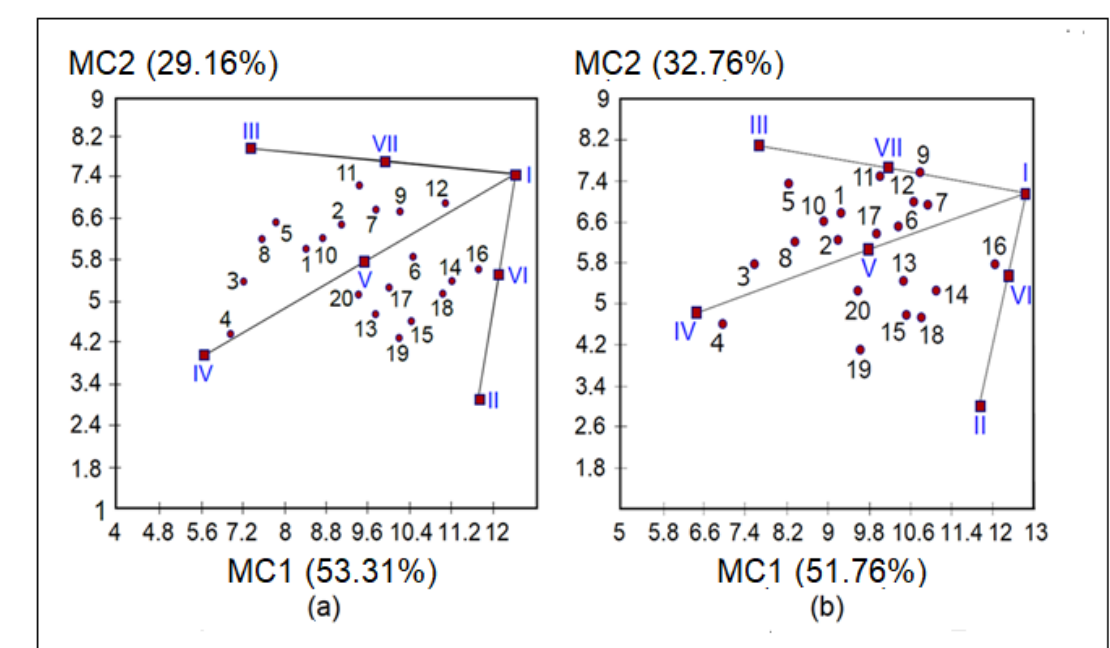
Figure 1. Graphic dispersion of the first two main components of 20 sugarcane genotypes. In ( a ), a graph constructed based on TSH. In ( b ), a graph constructed based on TFH. Ideotypes: I—Maximum general adaptability; II—Maximum adaptability to favorable environments; III—Maximum adaptability to unfavorable environments; IV—Little adapted; V—Average general adaptability; VI—Average adaptability to favorable environments; and VII—Average adaptability to unfavorable environments.